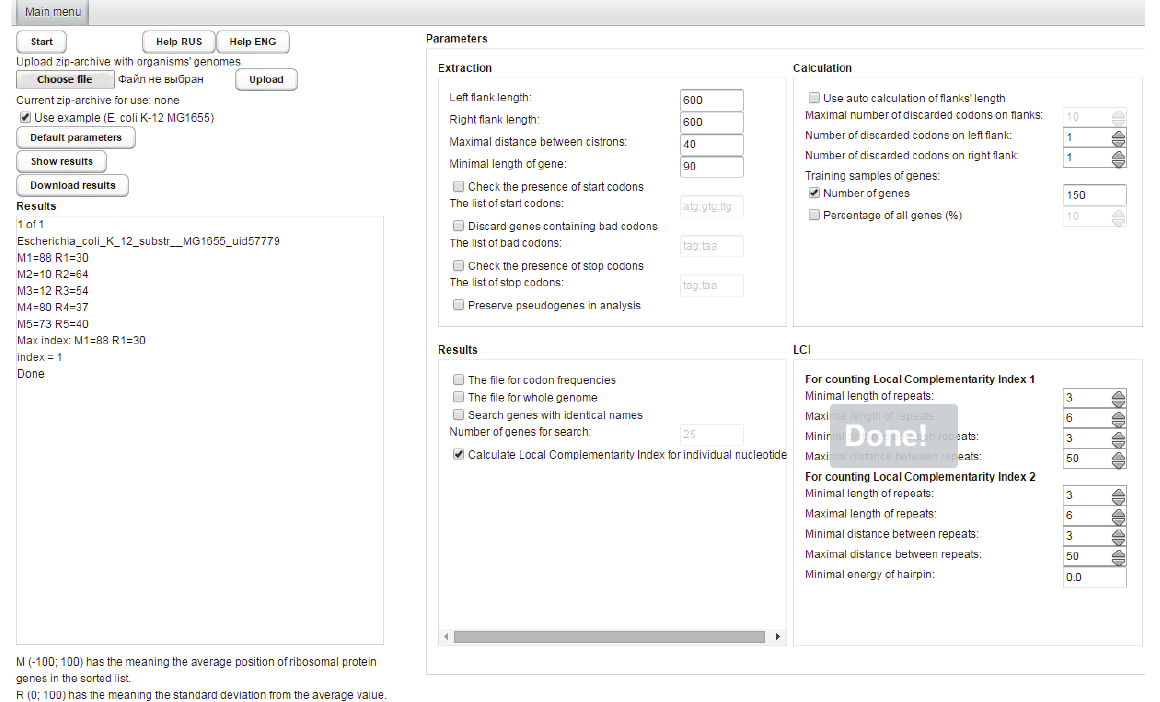
Figure 1: The interface of the EloE web application. The Choose file, Upload, Start and Download results buttons in the upper left corner allow running the EloE application and getting all files with results. Calculated indices are displayed in the Results area. The Parameters area allows to change some calculation parameters (see